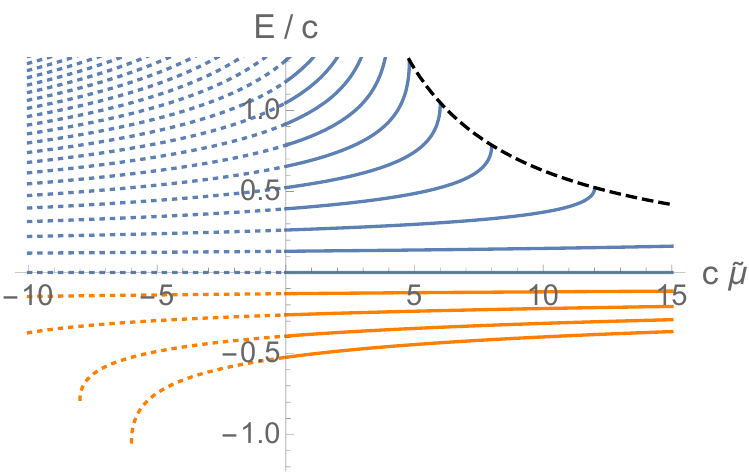
Figure 1 . The energy levels E n at L = 2 (cid:25) and J = 0 as a function of (cid:22) for di(cid:11)erent values of E (0) = (cid:1) n + (cid:22)(cid:1) n (cid:0) c . States with E (0) > 0 that correspond to black holes in holographic CFTs 12 are plotted in blue, while low-lying states are plotted in orange. For (cid:22) > 0 that is the relevant regime in our study we used solid lines, while for (cid:22) < 0 the spectrum is plotted with dotted lines. The levels exhibit a square root singularity at the critical value (cid:22)E (0) = 2 (cid:25) . This indicates that, for given (cid:22) , the energy spectrum of the deformed CFT is bounded by E < 8 , indicated on the plot (cid:22) by a dashed black